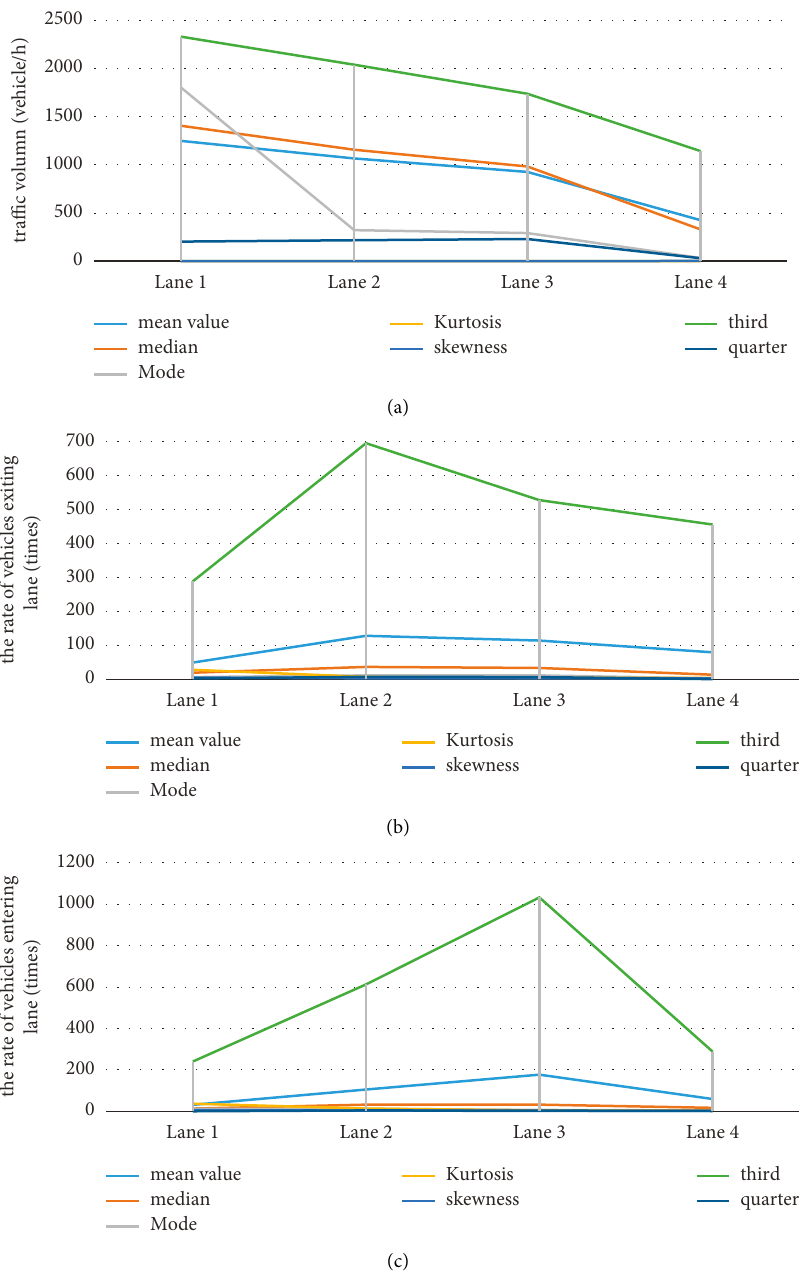
Figure 3: Distribution map of statistical characteristics of collected data on the 3rd Ring Road in Chengdu, China. (a) Distribution map of traffic volume by each lane. (b) Feature distribution map of the rate of vehicles exiting lane by each lane. (c) Feature distribution map of the rate of vehicles entering lane by each